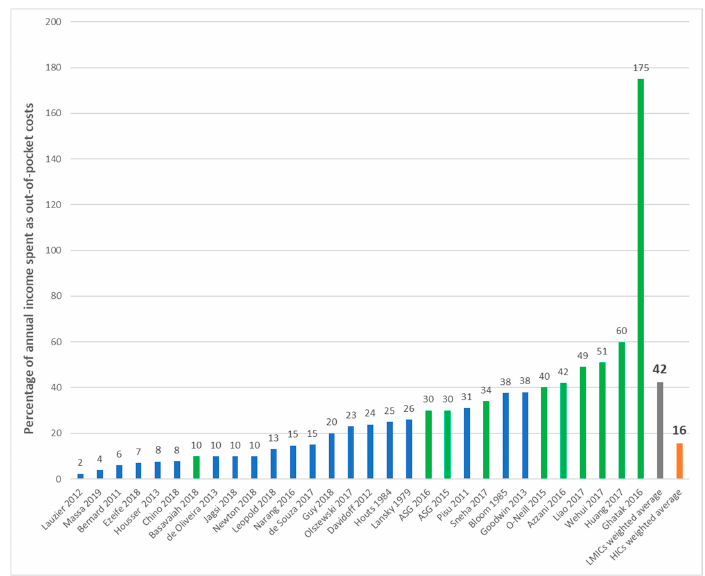
Figure 6. Average out-of-pocket costs per patient as a percentage of income. Legend: LMIC = low- and middle-income countries; HIC = high-income countries; ASG = Action Study Group; blue bars represent studies from HICs; green bars represent studies from LMICs. Note: This figure shows the costs from individual studies that estimated out-of-pocket expenditures relative to annual income. A weighted average was calculated for high-income countries (in green) and low- and middle- income countries (blue). Studies conducted in high-income countries include the U.S., Canada, and Australia. Studies conducted in low- and middle-income countries include China, Malaysia, India, Haiti, Brunei, Thailand, Indonesia, Philippines, Vietnam, Laos, Cambodia, and Myanmar.